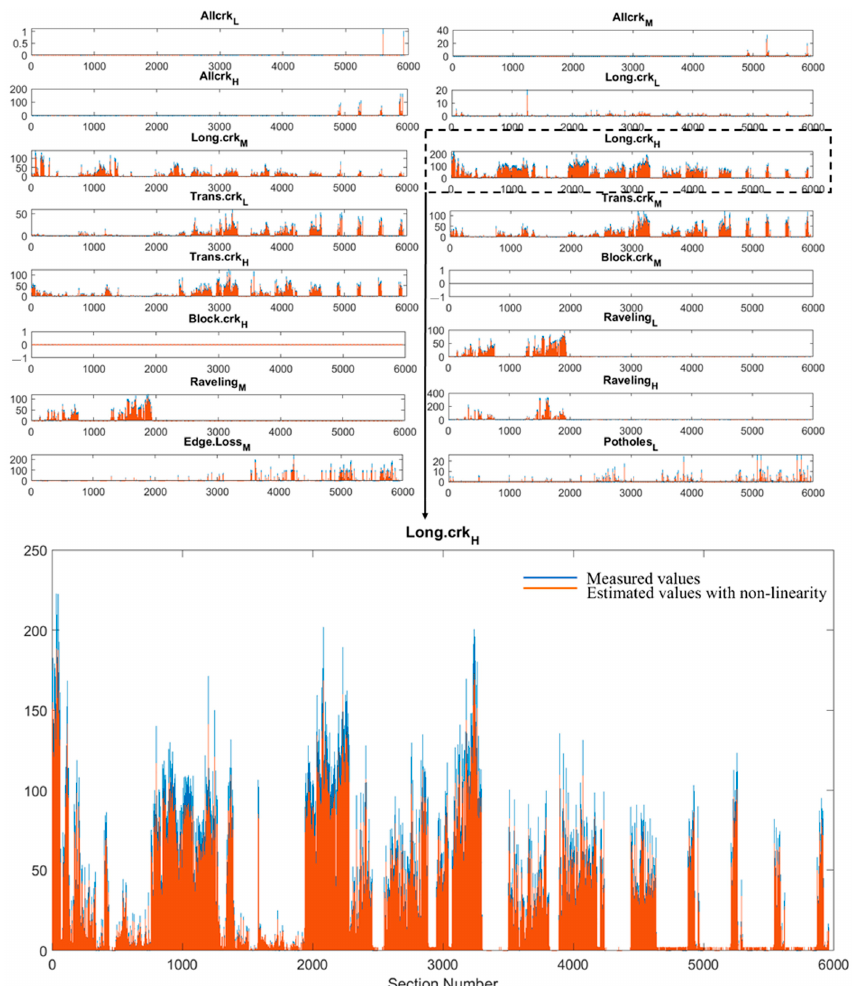
Figure 17. The measured values (blue) and the estimated values with nonlinearity (orange) for each of the metrics.